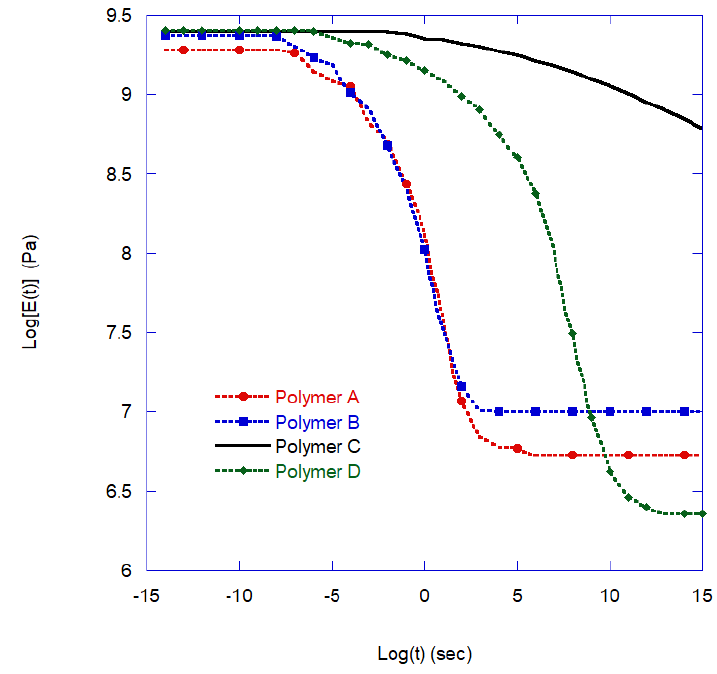
Figure 18. Master relaxation